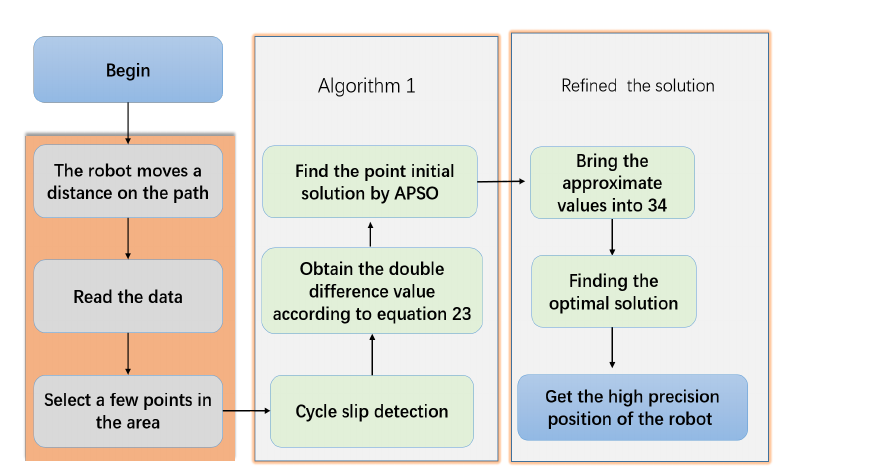
Figure 3. The high-precision positioning process of A-OTF